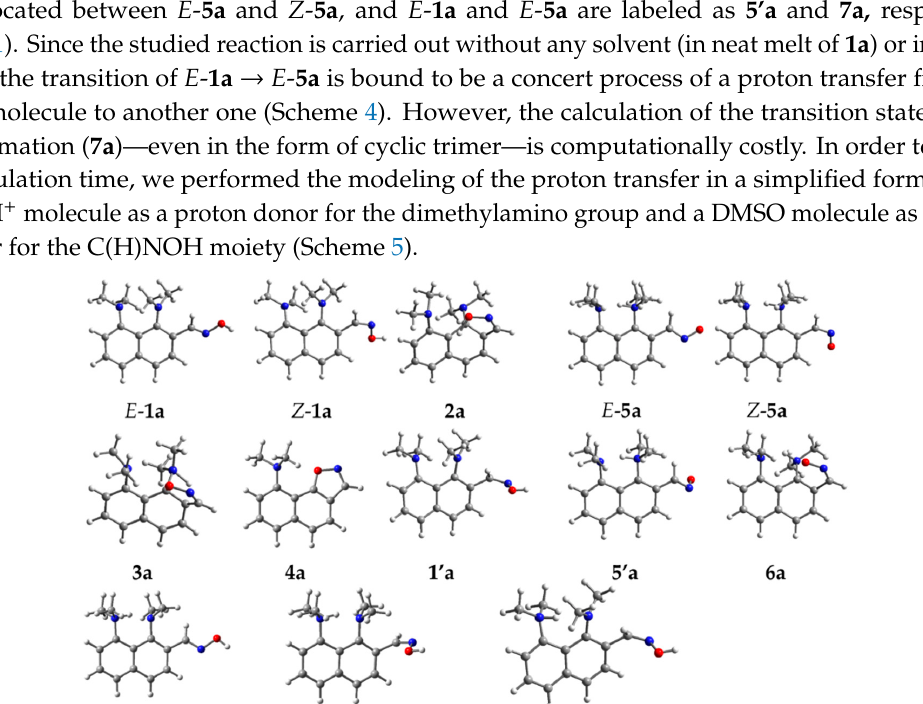
Figure 1. Optimized geometries of studied reaction intermediates for 1a → 4a transformation.